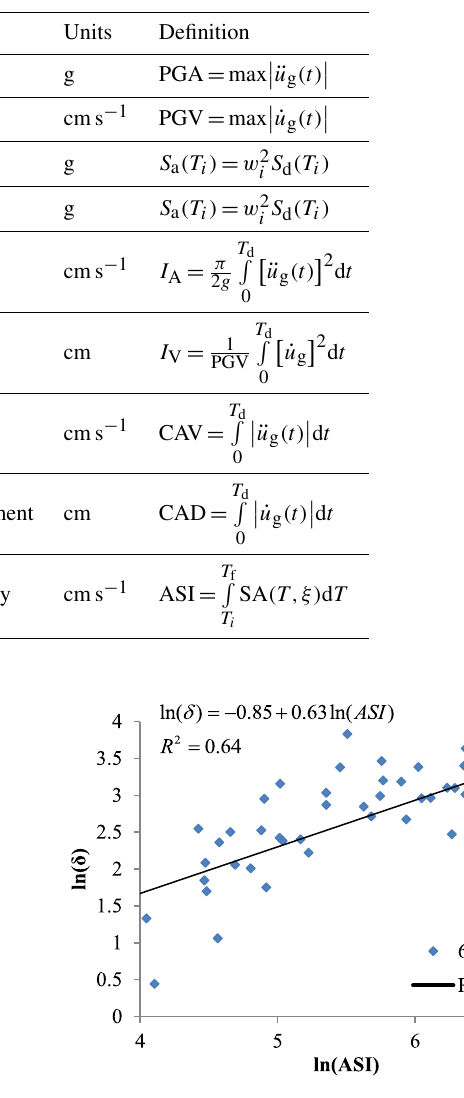
Figure 5. PSDMs for selected